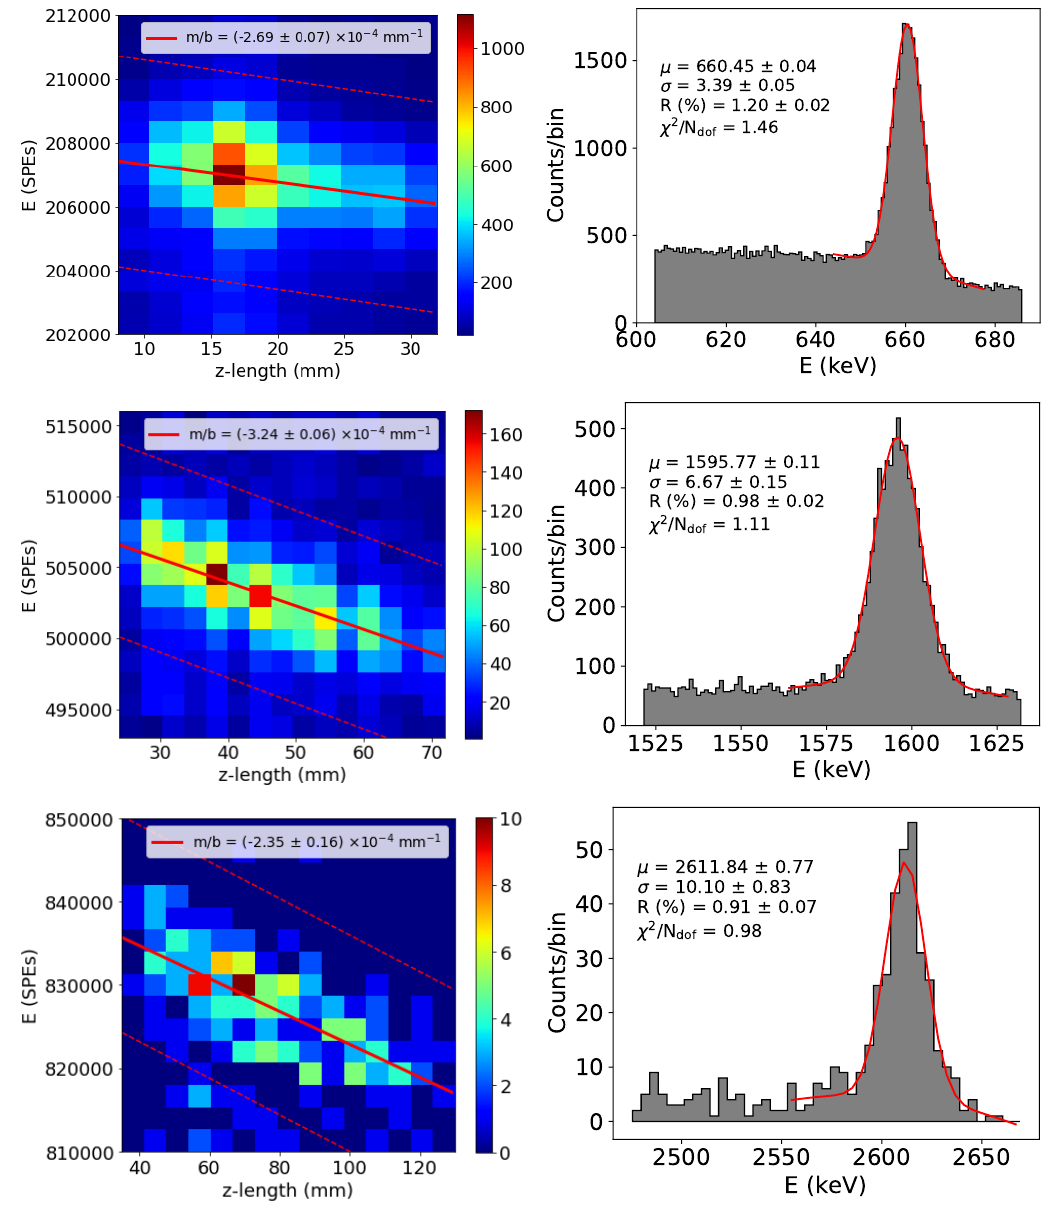
Figure 5 . Fits to the dependence of energy on track length in the axial dimension (left), and the resulting energy spectra of three energy peaks (nominally at 662 keV, 1592 keV, and 2615 keV) after application of all corrections, including a linear correction to the energy (equation (3.1)) corresponding to the average value of ( m=b ) = 2 : 76 (cid:2) 10 (cid:0) 4 obtained from the 3 (cid:12)ts (right).